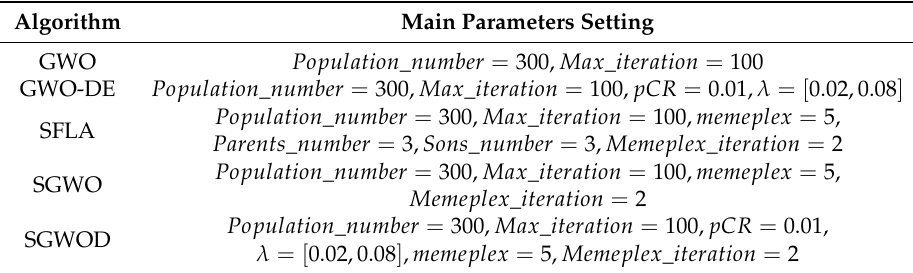
Table 5. Parameters setting of each